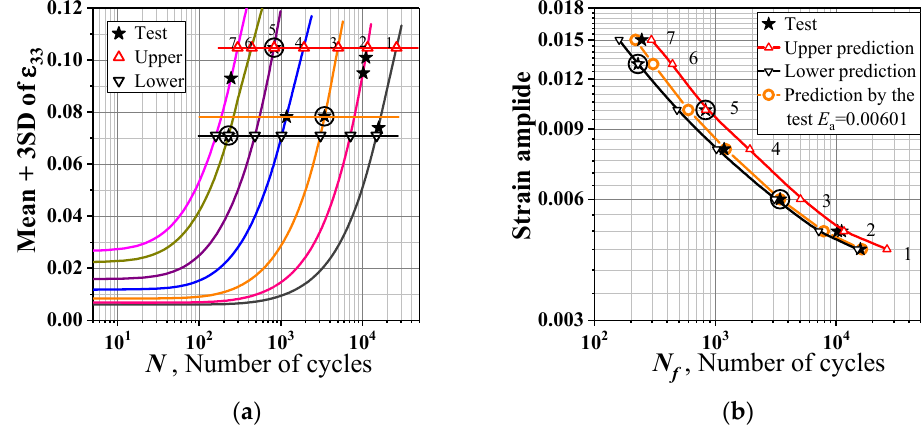
ˆ3 ε ε+ : ( a ) determining upper and 33 33 N E ; ( b ) predicted fatigue–life , E a ) ; ( b ) predicted fatigue–life curves and f a f